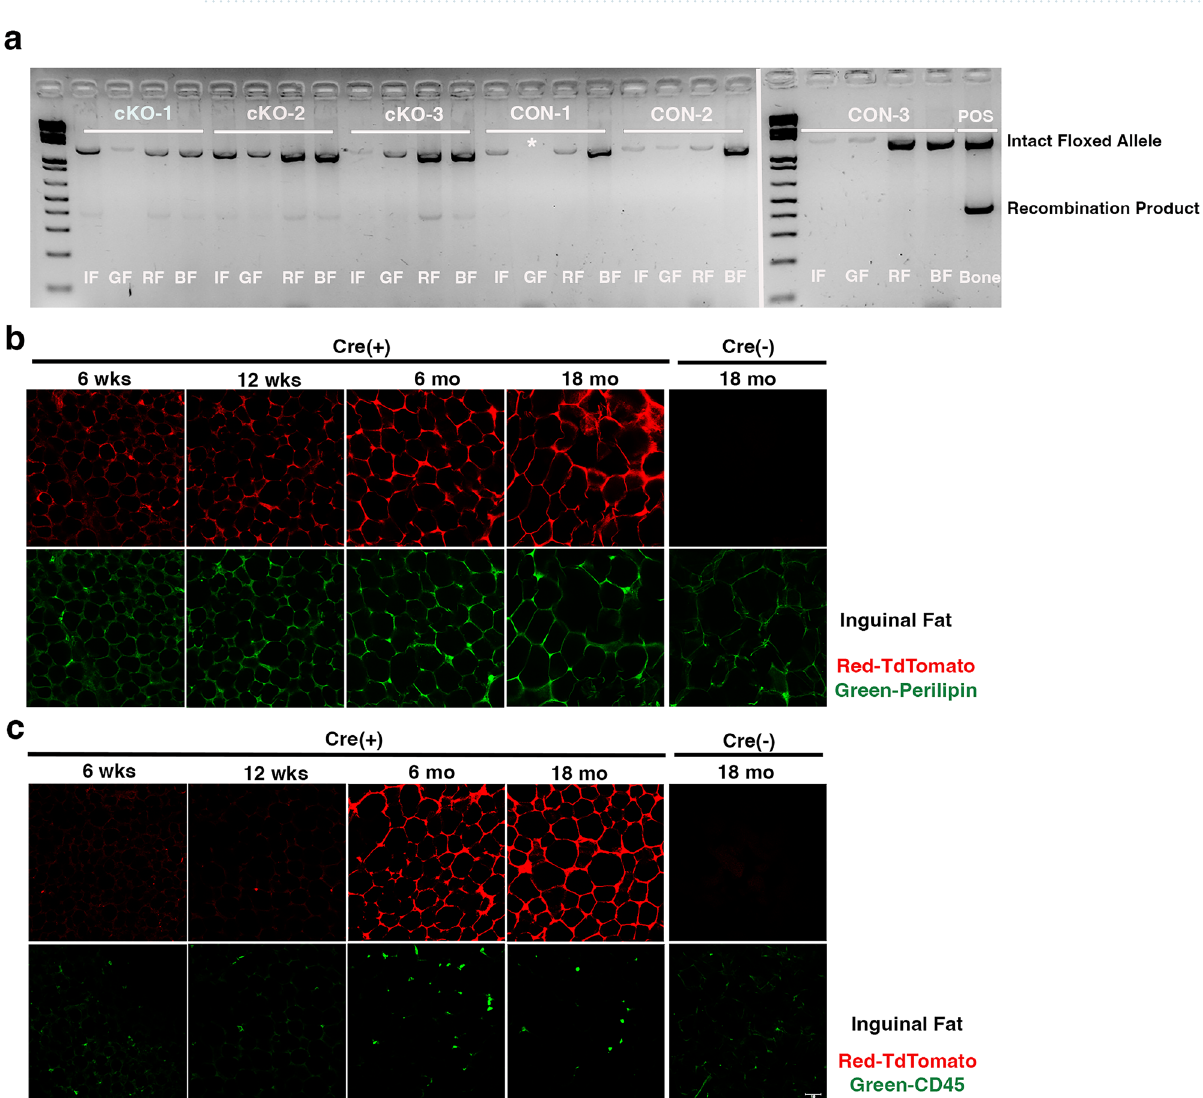
Figure 5. Osx-Cre mediates recombination in peripheral adipocytes. ( a ) PCR of genomic DNA from inguinal fat (IF), gonadal fat (GF), renal fat (RF), and brown fat (BF), isolated from 15 mo male mice. Whole, flushed bone was used as a positive control (POS). Intact floxed allele = 1.3 kb and recombination product = 460 bp. *, sample lost in loading. Right panel was originally on the bottom row of the same gel as the left panel. n = 3 biological replicates. Representative immunofluorescence staining for ( b ) Perilipin (green) or ( c ) CD45 (green) in inguinal fat from Osx-Cre;TdT reporter mice (red) at 6 wks, 12 wks, 6 mo, 18 mo, or Osx-Cre control mice at 18